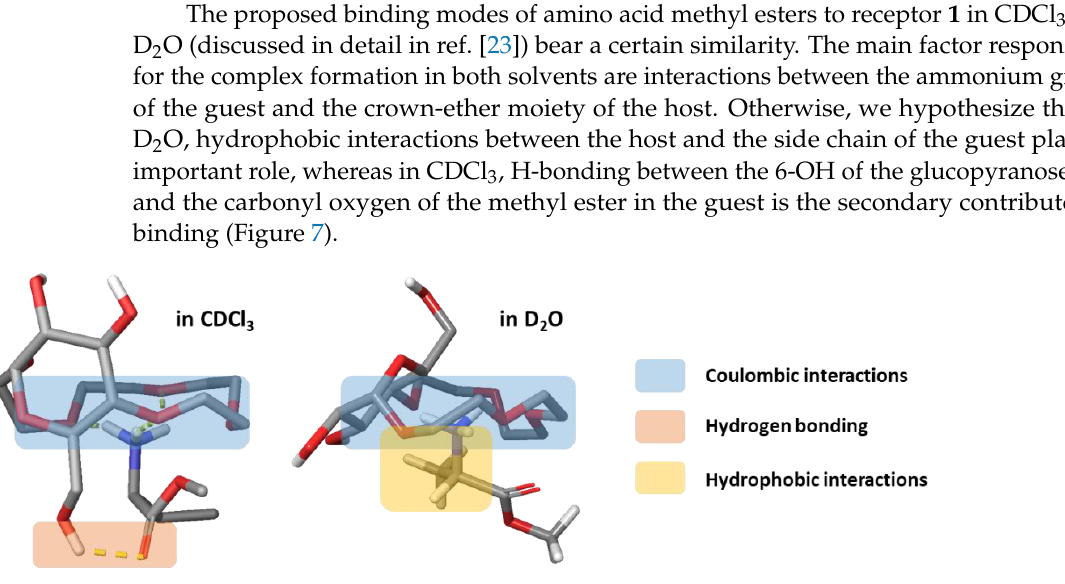
Figure 7. Proposed binding modes of L -amino-acid methyl esters by 1 in CDCl 3 ( left ) and D 2 O ( right ). The main interactions contributing to the binding are marked with colored rectangles.